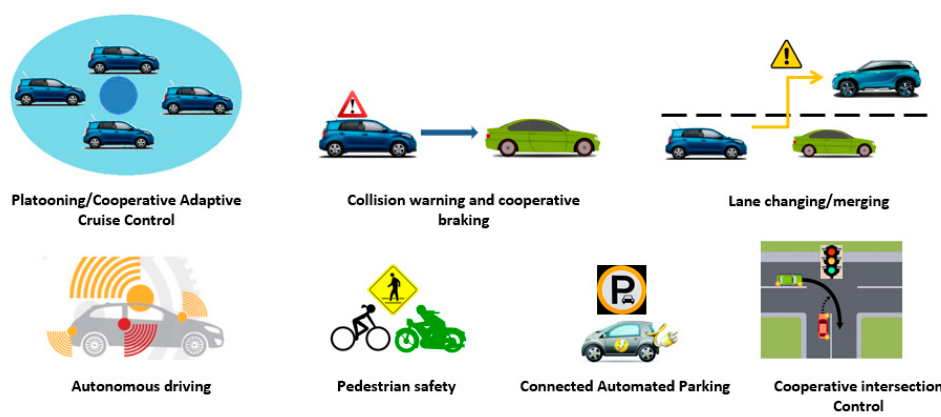
Figure 3. Proposed use cases facilitated by C-V2X support.